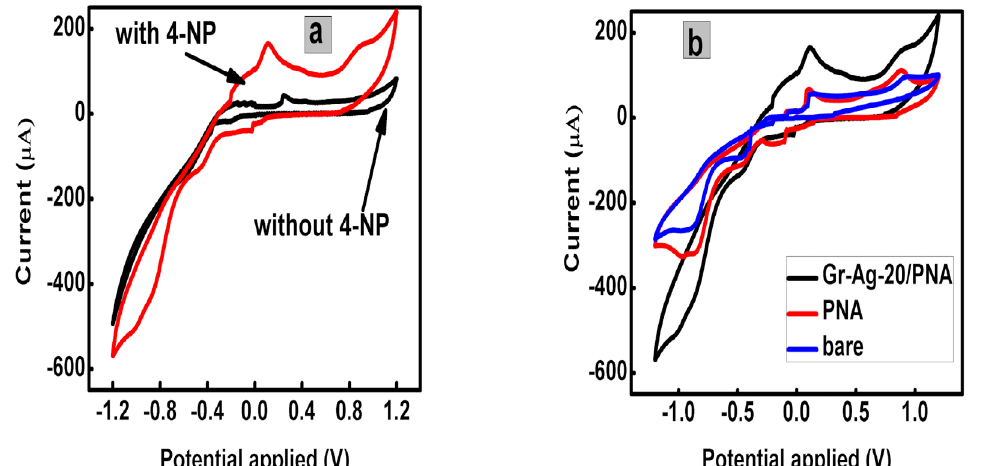
Fig.6 Nyquist plots of CPE (a), PNA/CPE (b), Gr-Ag-5/PNA/CPE (c), Gr-Ag-10/PNA/CPE (d), and Gr-Ag-20/PNA/CPE (e)